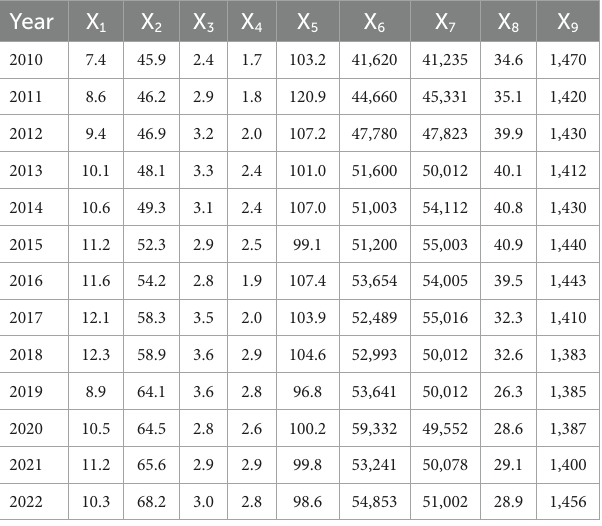
TABLE 3 Data description of influence factors.